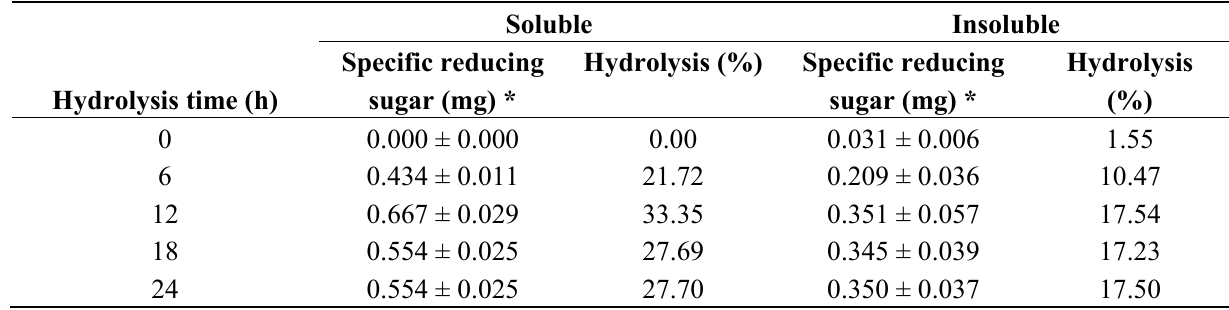
Table 5. Hydrolysis of soluble or insoluble birchwood xylan catalyzed by purified Xyl-O1. Soluble Insoluble Specific reducing Hydrolysis (%) Specific reducing Hydrolysis sugar (mg) * sugar (mg) * (%) Hydrolysis time (h) 0 0.000 ±